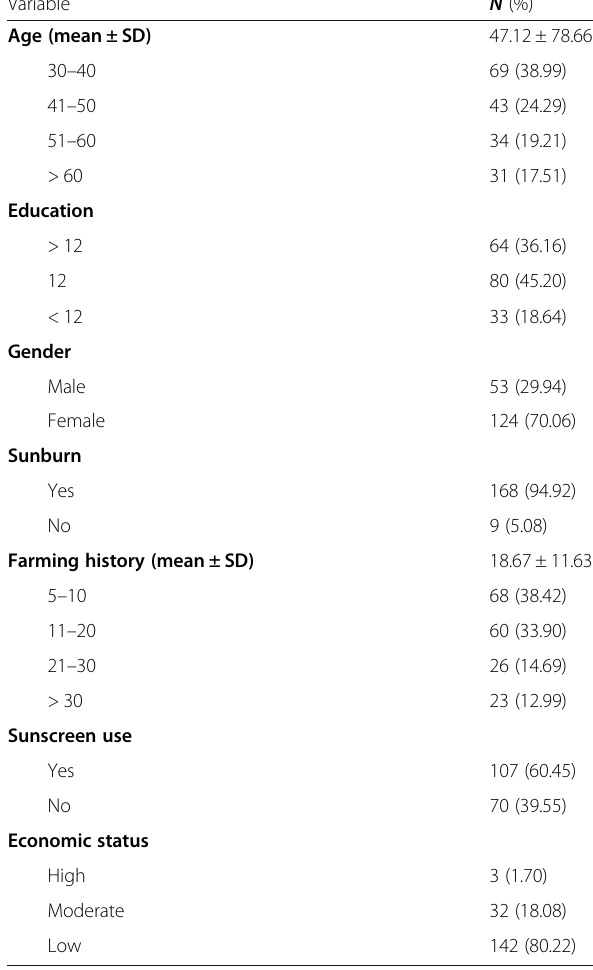
Table 1 The demographic characteristics of the ( n = 177)